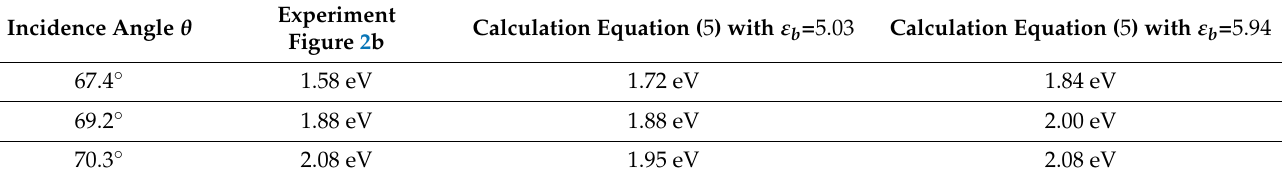
Table 1. The background dielectric constant ε b of Ag, experimentally determined from the fit of the observed surface plasmon polariton (SPP) resonance wavelength to Equation (5) with (cid:125) ω p = 3.82 eV. Experiment Incidence Angle θ Calculation Equation ( 5 ) with ε b = 5.03 Calculation Equation ( 5 ) with ε b = Figure 2b